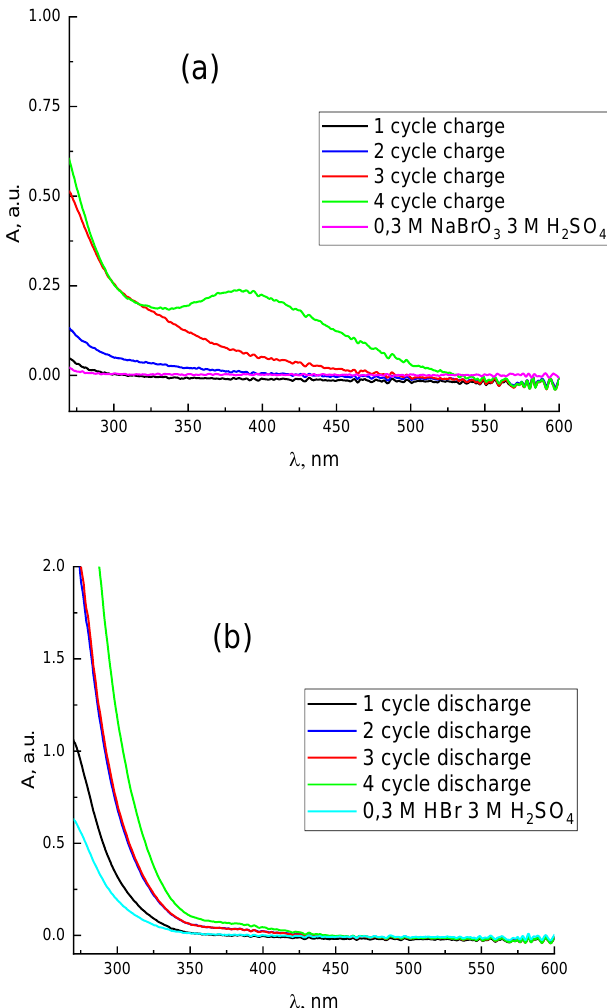
Figure 7. Spectra of the catholyte at the end of the charge ( a ) and discharge ( b ) of each cycle of operation of a hydrogen-bromate flow battery .